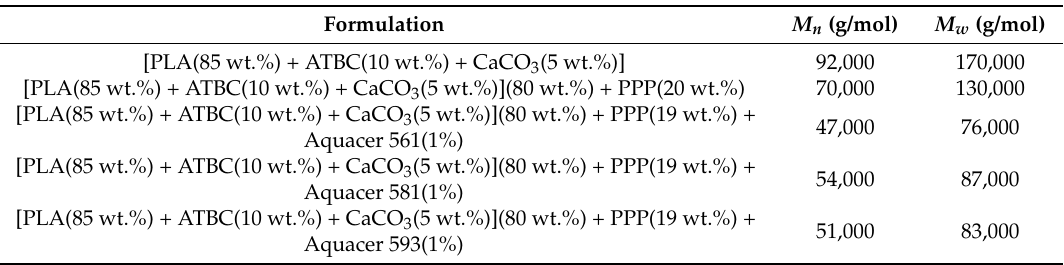
Table 3. Number-average molar mass ( M n ) and mass-average molar mass ( M w ) of PLA in the matrix and